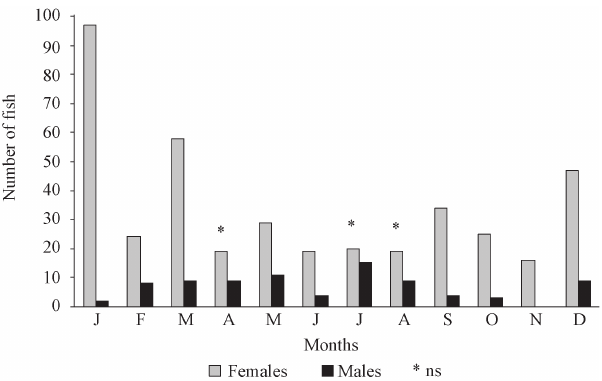
Fig. 3. Monthly sex ratio for Poecilia sphenops in the Emiliano Zapata Reservoir. Asterisks indicate not significant differences.